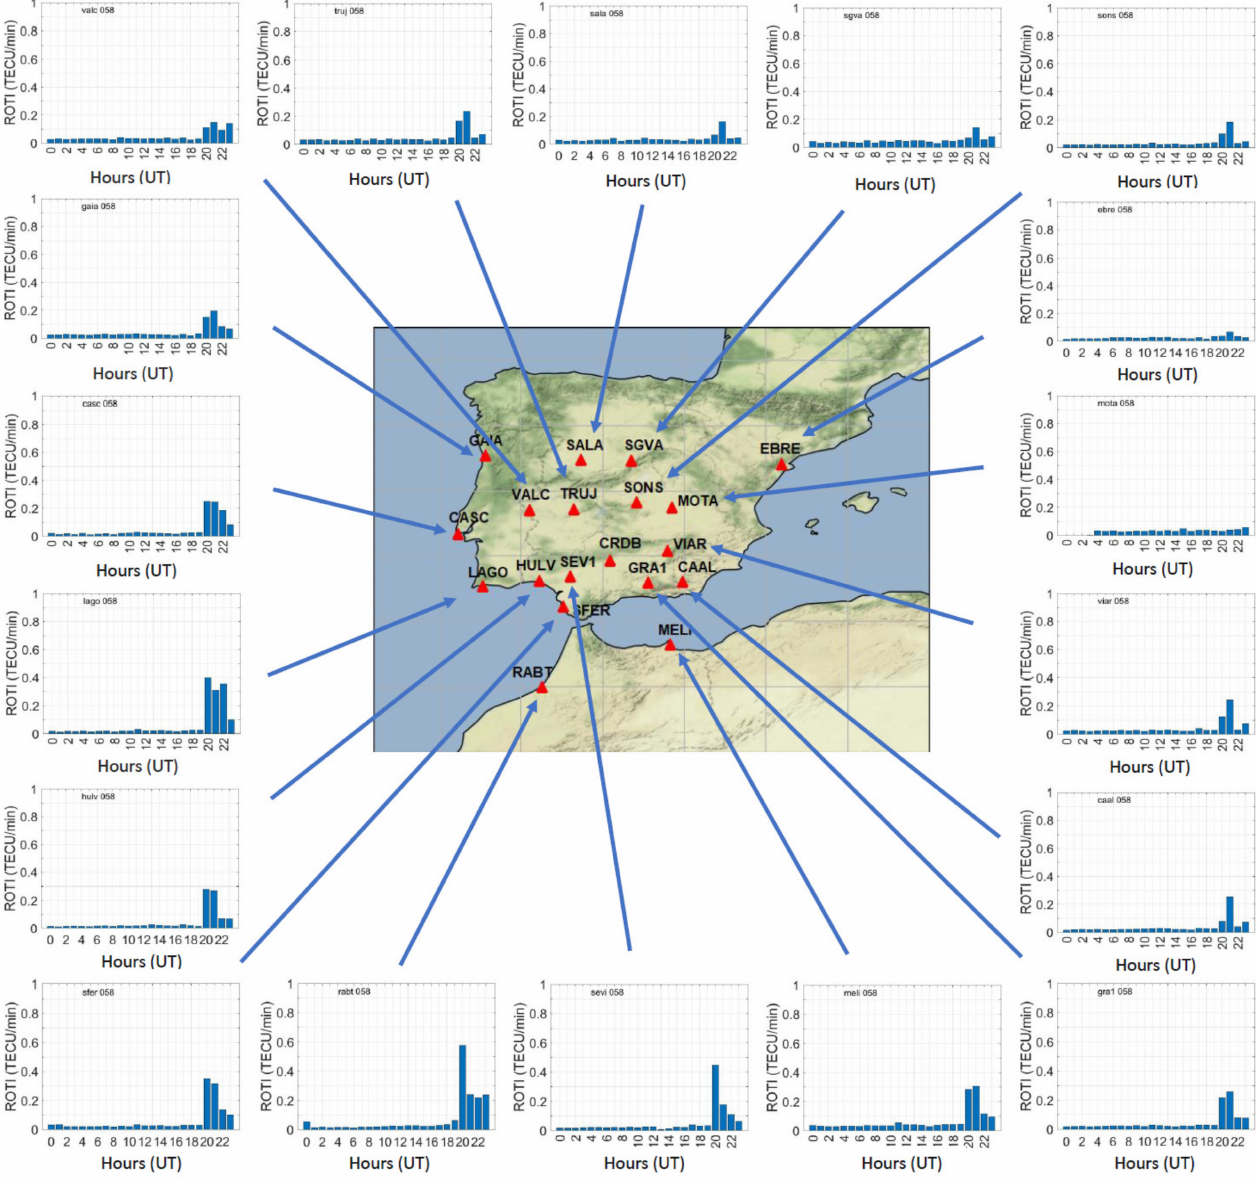
Figure 5. Map of GNSS receiver stations and hourly averaged ROTI plots during the day of the main phase of the 26–27 February 2014 geomagnetic storm (24 h on 27 February 2014): GAIA (41.1 N, 8.6 W), SALA (41.0 N, 5.7 W), SGVA (40.9 N, 4.1 W), EBRE (40.8 N, 0.5 E), VALC (39.4 N, 7.2 W), TRUJ (39.5 N, 5.9 W), SONS (39.7 N, 4.0 W), MOTA (39.5 N, 2.9 W), CASC (38.7 N, 9.4 W), LAGO (37.1 N, 8.7 W), HULV (37.3 N, 6.9 W), SEV1 (37.4 N, 6.0 W), CRDB (37.9 N, 4.8 W), VIAR (38.2 N, 3.0 W), SFER (36.5 N, 6.2 W), GRA1 (37.2 N, 3.6 W), CAAL (37.2 N, 2.5 W), RABT (34.0 N, 6.9 W), MELI (35.3 N, 2.9